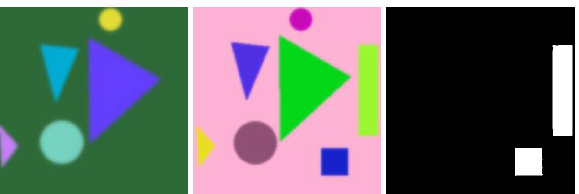
Figure 6. Change detection on synthetic images with small relative shift of objects: left – input image A, middle – input image B, right – synthesized difference